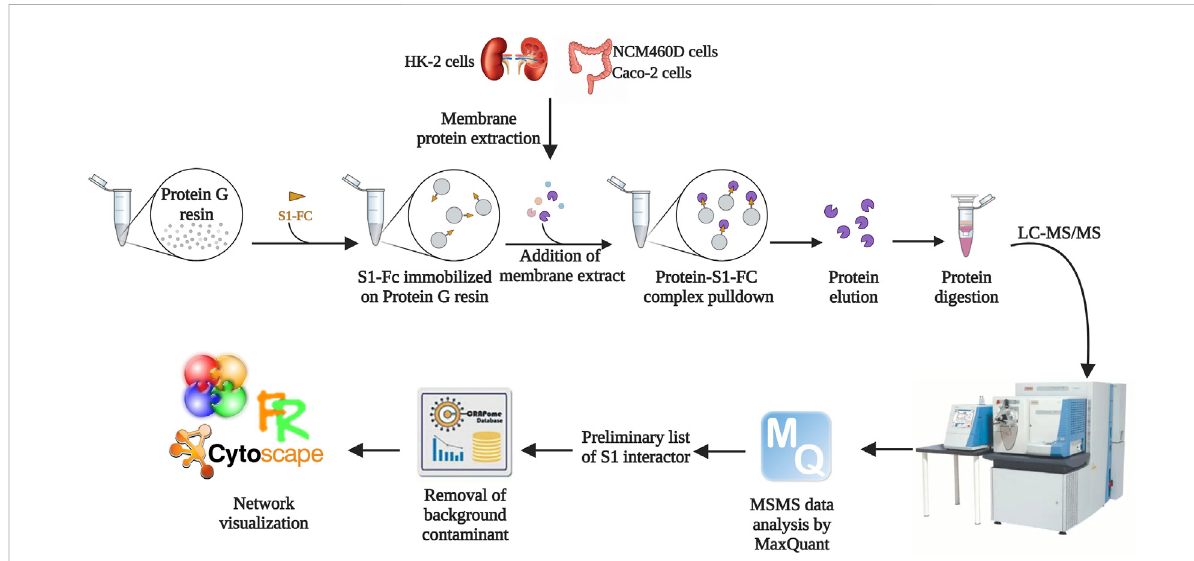
FIGURE 1 Work fl owoftheAP-MSapproachfollowedinthepresentstudy.ThesolidsupportwasfunctionalizedwitharecombinantformofS1.Membrane proteinextractsderivedfromHK-2,NCM460D,andCaco-2celllineswereincubatedwiththeresin,andtheretainedproteincomplexeswereeluted indenaturingconditions.Thesamplesweresubjectedtoashotgunhydrolysisprotocolusingtrypsinastheproteolyticenzyme.Thepeptidemixtures were analyzed by nano LC-MS/MS and proteins were identi fi ed by the software MaxQuant. The preliminary lists obtained discarding the proteins identi fi ed in the negative controls were further fi ltered with the contaminant database CRAPome. The fi nal lists were analyzed by bioinformatics tools such as